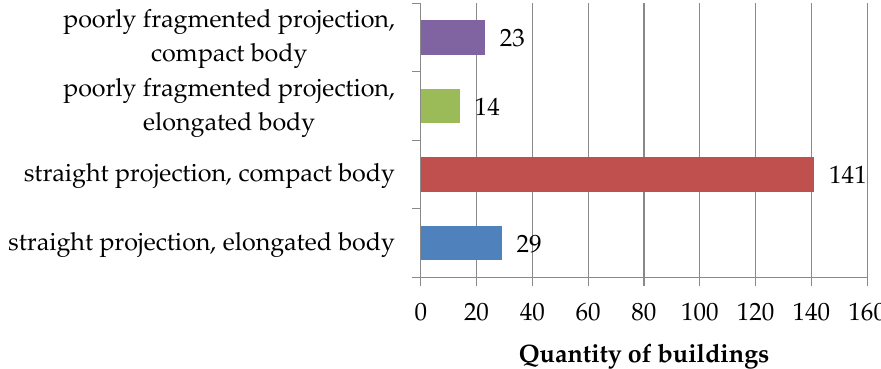
Figure 12. Distribution of data for the variable relating to the shape of a building.